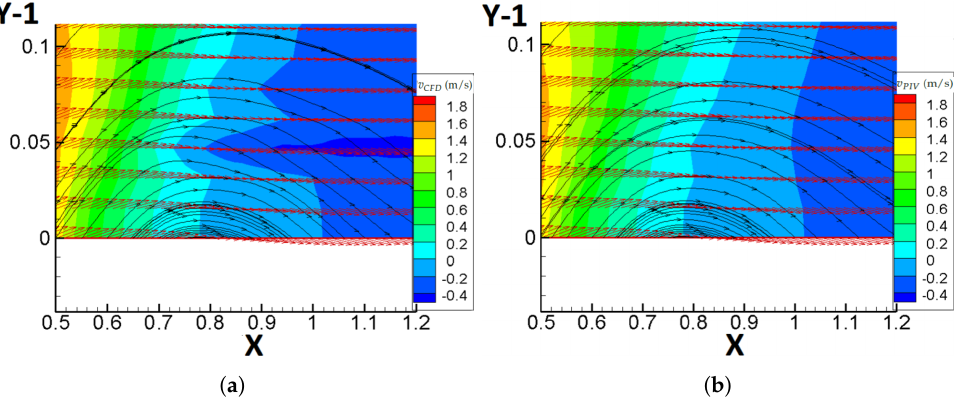
Figure 10. Contours of v (m/s), vectorial fields of u t and streamlines (in the same figure), on a region near the south boundary of plane B, extracted by: ( a ) CFD methodology ( v CFD ), ( b ) PIV experimental technique ( v PIV ). X and Y are non-dimensional coordinates (non-dimensional distance of 1 corresponds to 1 cube height). Flow is from left to